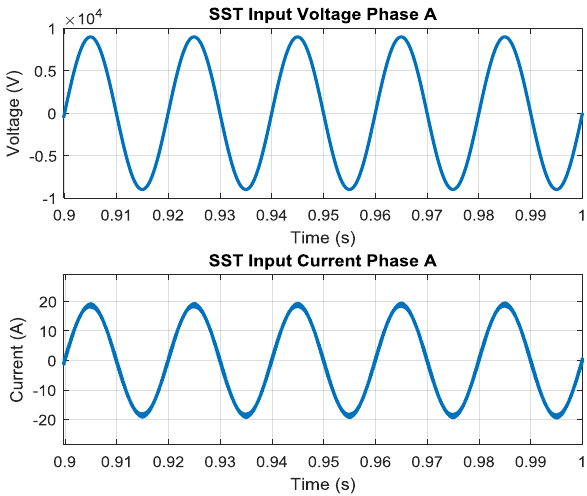
Figure 19. Result displaying that phase A voltage and current are in phase.